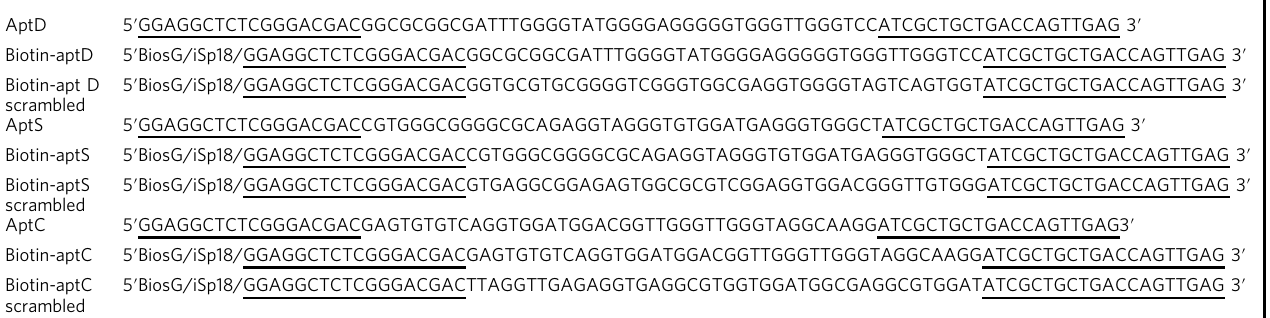
Table 2 Sequences of aptamers and control